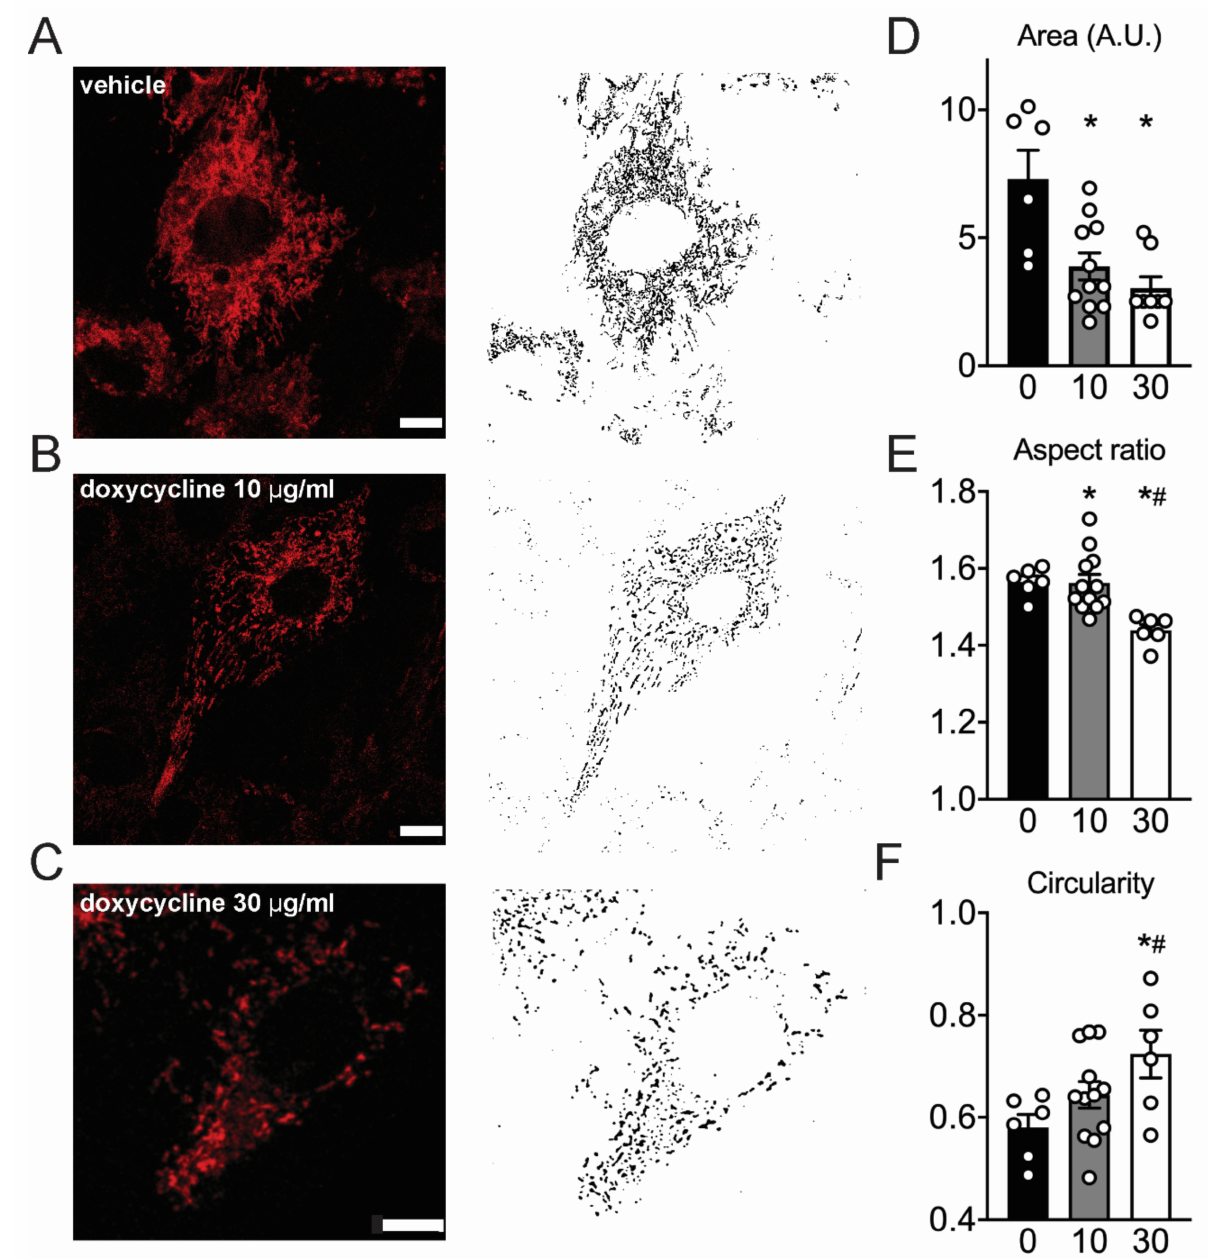
Figure 3. Mitochondria appear more fragmented in doxycycline-treated H9C2 cells. ( A – C ), representative H9C2 cells loaded with TMRM with corresponding masks for quantification. ( D – F ), Mitochondria in doxycycline-treated H9C2 cells appeared more fragmented, were smaller, had lower aspect ratios and higher circularity compared to vehicle. Values are median (area and aspect ratio) or 25% percentile values (circularity) because of non-normal distribution. n = 5–12 independent samples per group on four different days. Error bars are SEM. Scale bar: 10 µ m. *: p < 0.05 vs. vehicle; #: p < 0.05 vs. 10 µ g/mL doxycycline, one-way ANOVA followed by Tukey’s post-hoc test for multiple